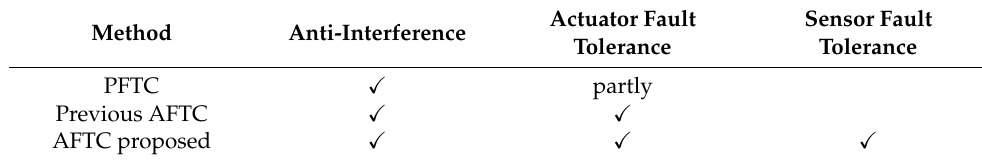
Table 1. Capability of different control